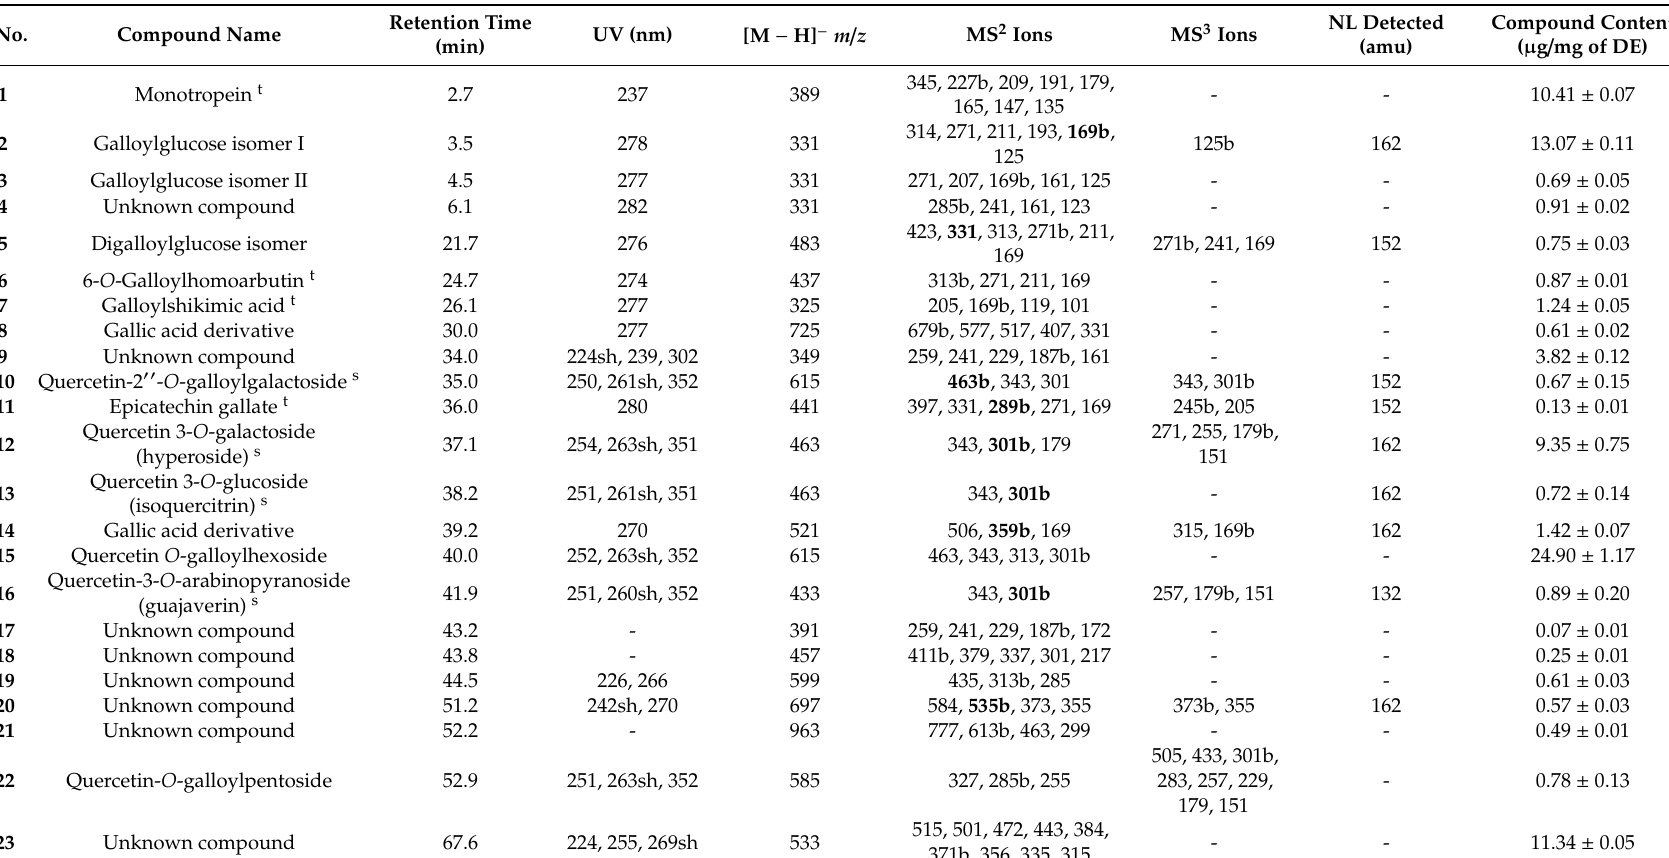
Table 2. The ultra-high performance liquid chromatography diode array detector tandem mass spectrometry (UHPLC-DAD-MS 3 ) data for compounds detected in the leaves of P. rotundifolia